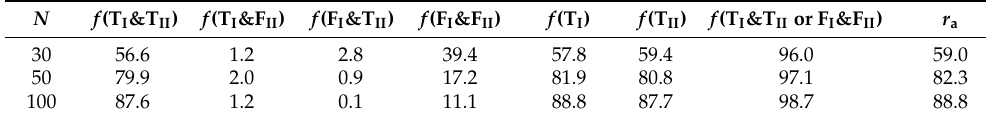
Table 3. Judgement for trend test results in simulation experiment 1 at the 5% significance level. Unit: %.